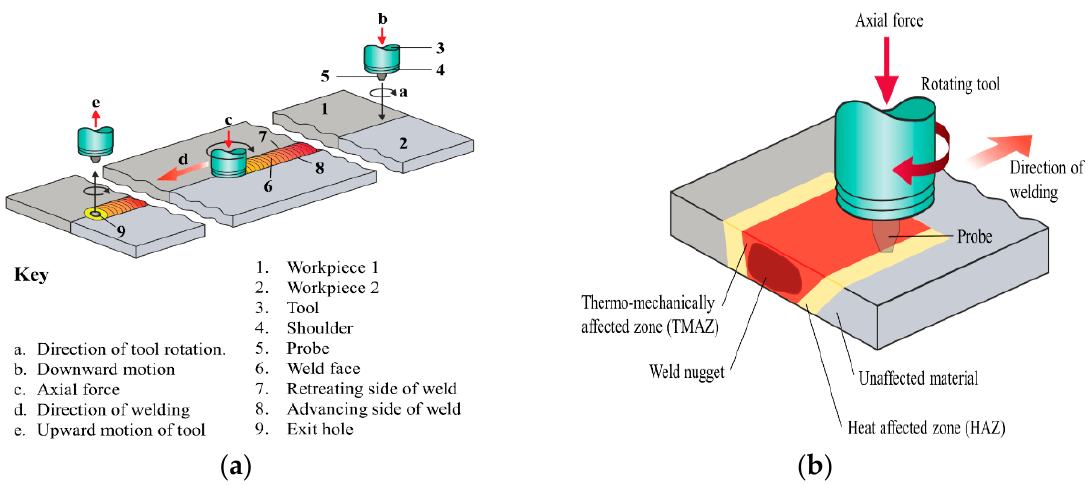
Figure 1. ( a ) Operating principle and components of conventional friction stir welding (FSW) and ( b ) different zones occurring during the FSW process.